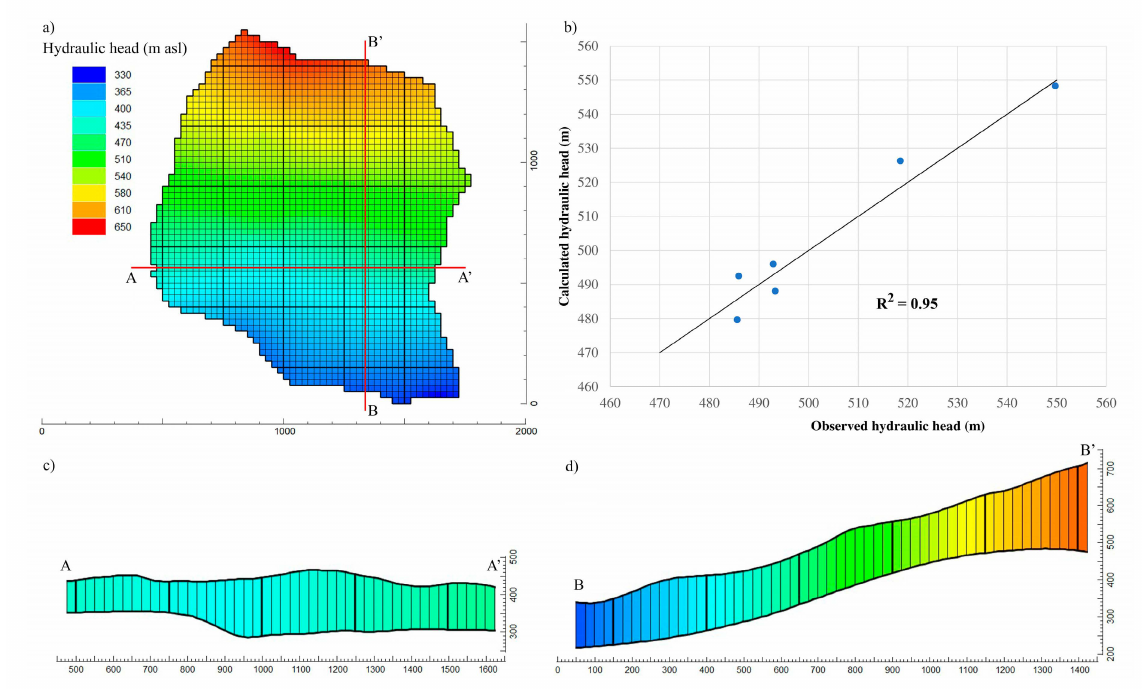
Figure 9. ( a ) Hydraulic head distribution at the end of the optimization procedure; ( b ) scattergraph of the observed and calculated hydraulic head values; ( c ) hydraulic distribution in cross sections A-A’ and ( d ) B-B’ also displayed in Figure